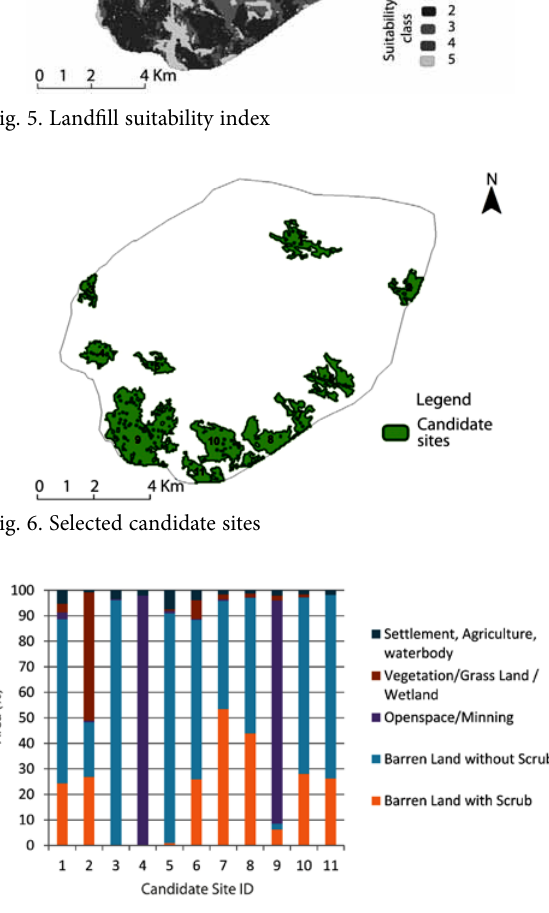
Fig. 7. Comparison of all the candidate sites with respect to land-use